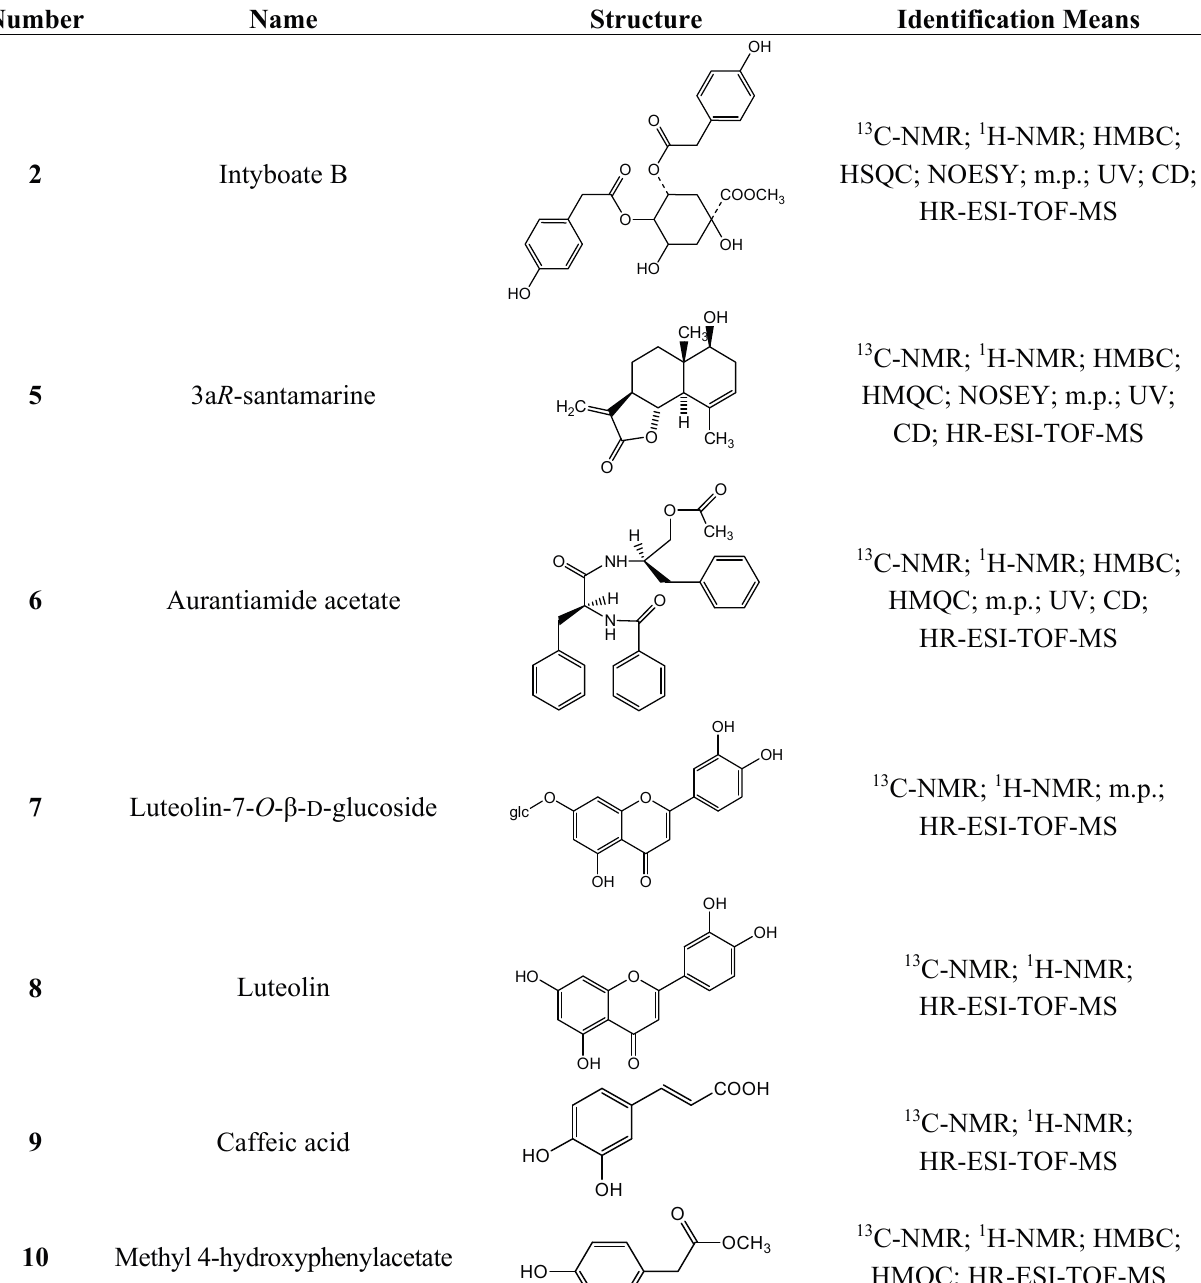
Table 1. The structures of compounds in Cichorium intybus